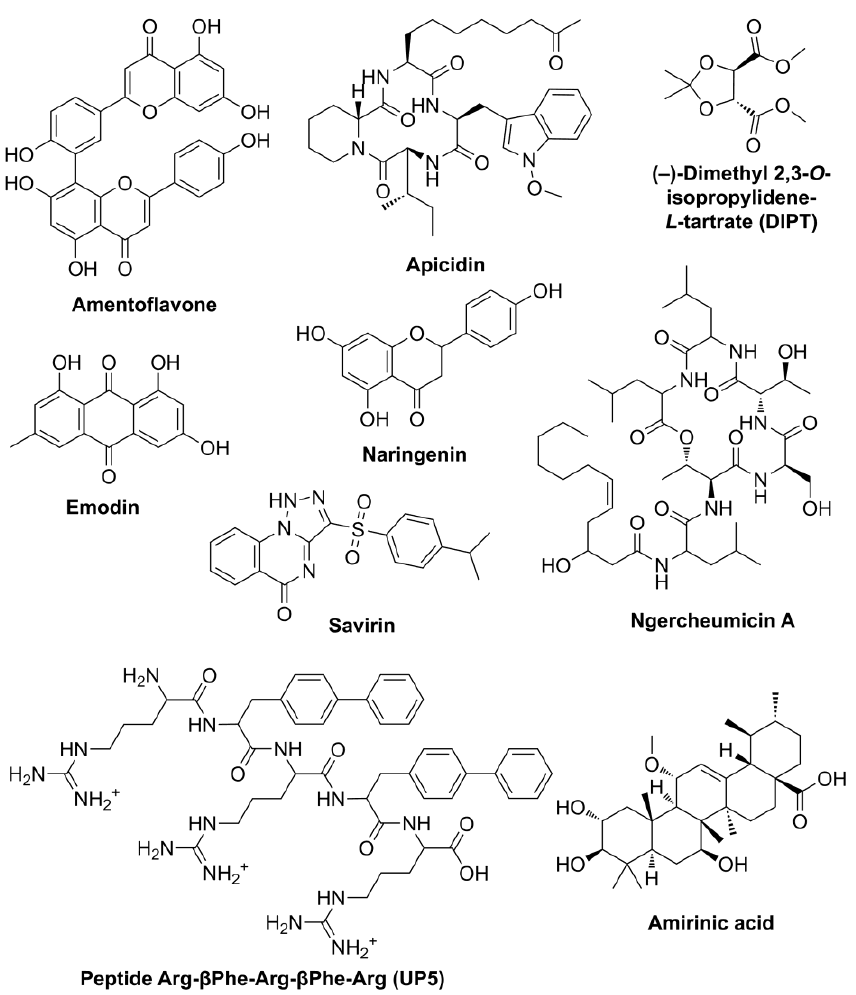
Figure 1. Chemical structures of selected substances interfering with QS systems of Gram-positive bacteria.